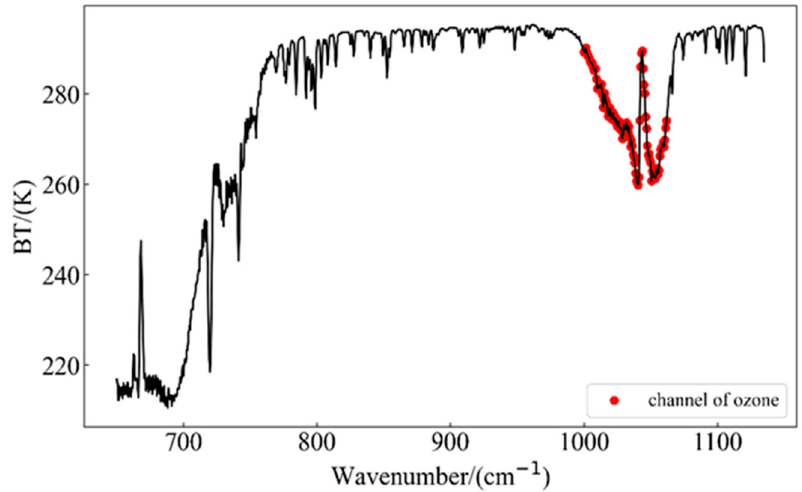
Figure 2. The position of the ozone channel in the spectrum. The concentration of the ozone channel near 1000 cm − 1 and the peak of the weight function covering most of the barosphere provide the basis for the ozone retrieval